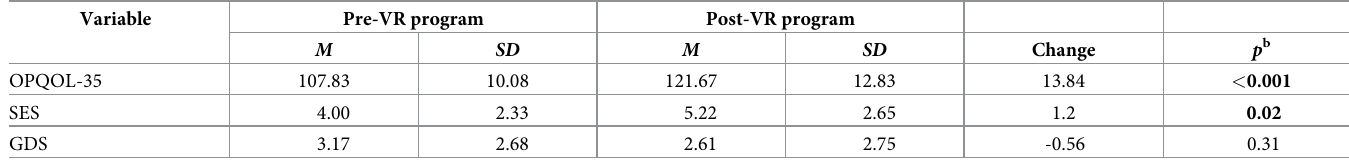
M = Mean; SD = Standard deviation; OPQOL-35 = Older People’s Quality of Life Questionnaire; SES = Social Engagement Scale; GDS = Geriatric Depression Scale. Change score was calculated by subtracting pre-VR tourism program score from post-VR tourism program score (i.e., T2 –T1). a Significance for home subscale of OPQOL-35 derived from Sign test. b Significance values derived from paired t -tests. Bolded p -values are significant at p <